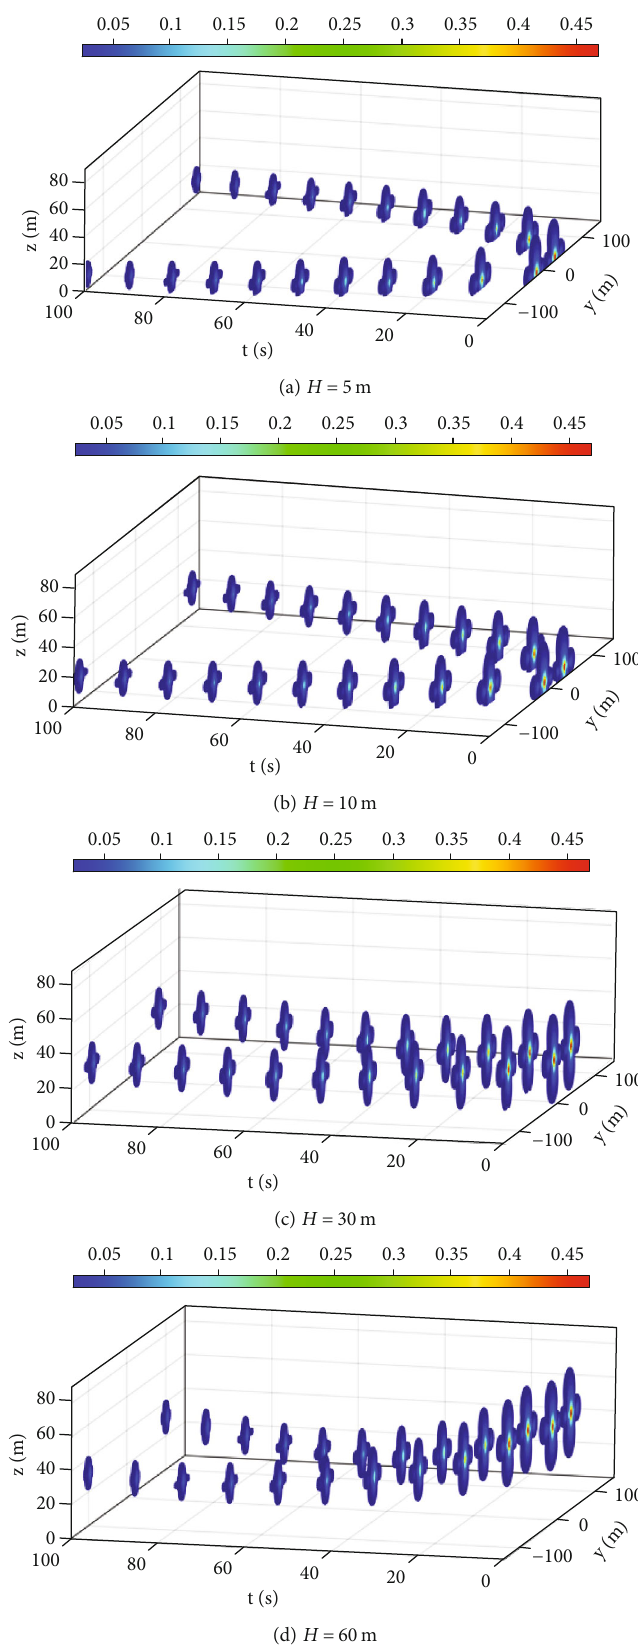
Figure 21: Variation in the roll hazard zone with time at di ff erent